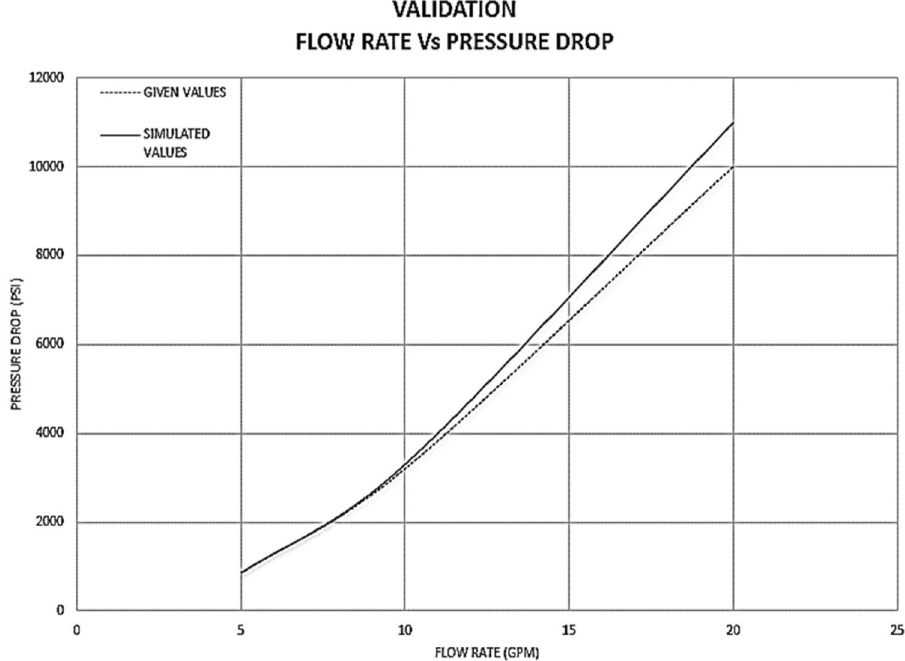
Fig. 7 Pressure drop versus flow rate plot to compare the given and simulated